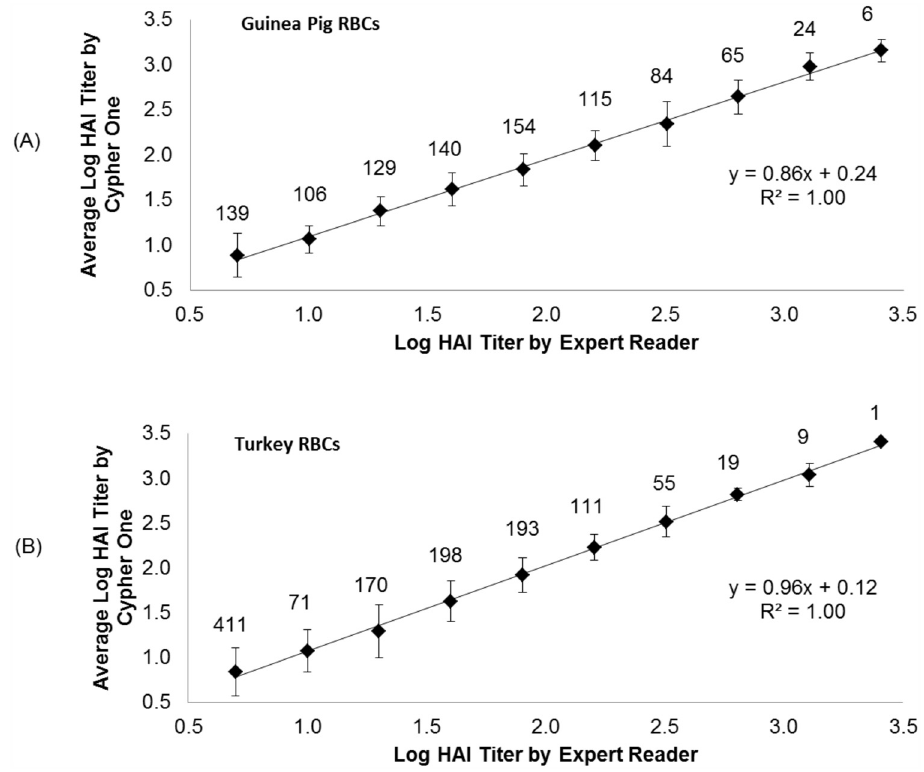
Fig 4. Log titer correlation plot for the guinea pig and turkey RBC datasets. (A) Shows the log titer correlationplot between interpretation methods for each assignedtiter value for the guineapig dataset. (B) Shows the log titer correlation plot betweeninterpretation methods for each assignedtiter value for the turkey dataset. The range of log titer values shown on the X axis reflect the titer values assignedby the human reader. The averageCypher One interpretation at all titer values is representedon the Y axis. Assignedtiter values rangedfrom 5 to 2560, or log titer values of 0.7 to 3.4, respectively. Log titer values of 0.7 (HAI titer of 5) exhibitedeither non-specificinhibitionor full agglutinationacross the entire dilutionseries. The number shown aboveeach data point indicatesthe number of samplesincludedin each data